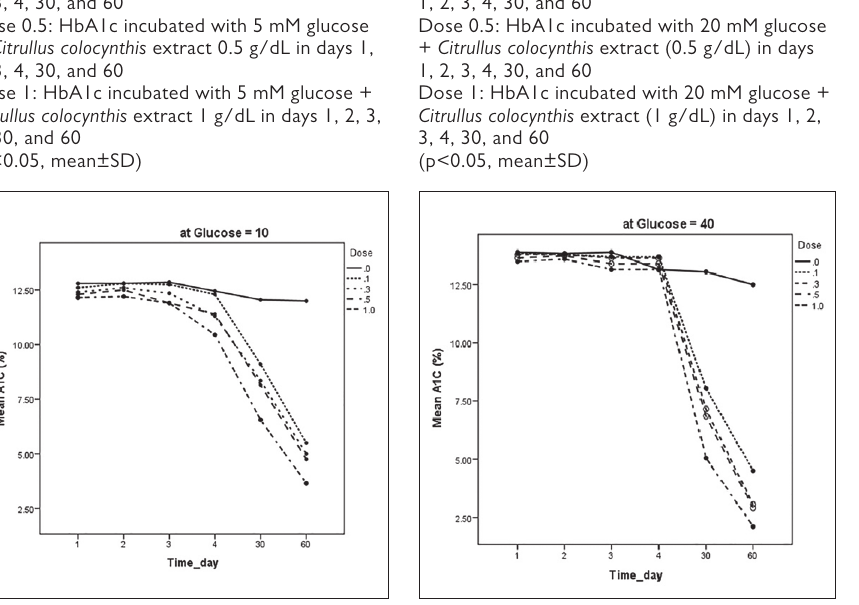
Figure 4. HbA1c incubated by 40 mM glucose and different doses of Citrullus colocynthis extract (0, 0.1, 0.3, 0.5, and 1 g/dL) in days 1, 2, 3, 4, 30, and 60 days Dose 0 or positive control: HbA1c incubated with 40 mM glucose in days 1, 2, 3, 4, 30, and